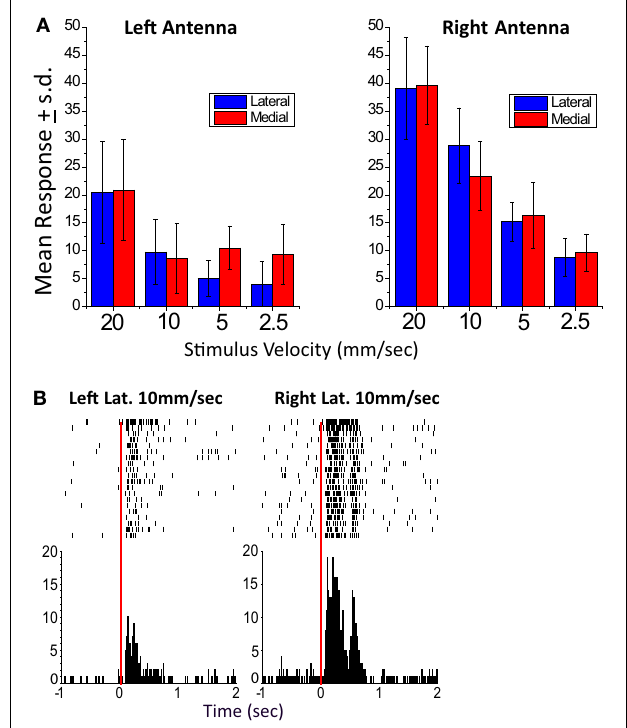
FIGURE 4 |A left-right biased unit recorded in the EB. (A) Mean response graphs of lateral and medial stimulation of the left and right antenna. For this unit, all response values for stimulus paradigms of the left antenna were tested against the comparable paradigms of the right antenna (Student’s t -test). All were significantly greater for the right antennae ( p < 0.01) except right and left medial 2.5mm/s which was significant at p < 0.05. (B) . Sample left and right lateral raster display (10mm/s stimulus velocity). In both records, the raster plots are of 20 responses of Left antenna moved laterally at 10mm/s (left) and Right antenna moved laterally at 10mm/s (right). In each case the top row is the first trial and the bottom the last.The time marks indicate the time that an action potential in this unit occurred. All records were lined up on the time at which the stimulation servo was activated (time 0).The histograms underneath the raster plots show the sum of all action potentials in 10ms bins. From Ritzmann et al.